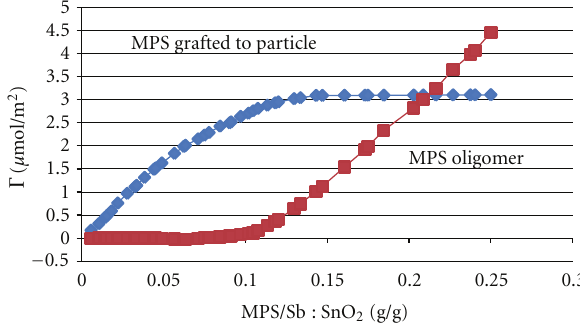
Scheme 3: Amount of MPS grafted on the surface of the Sb :SnO 2 nanoparticles surface and amount of MPS oligomer formed as a function of initial MPS/Sb:SnO 2 ratios used in the grafting reaction